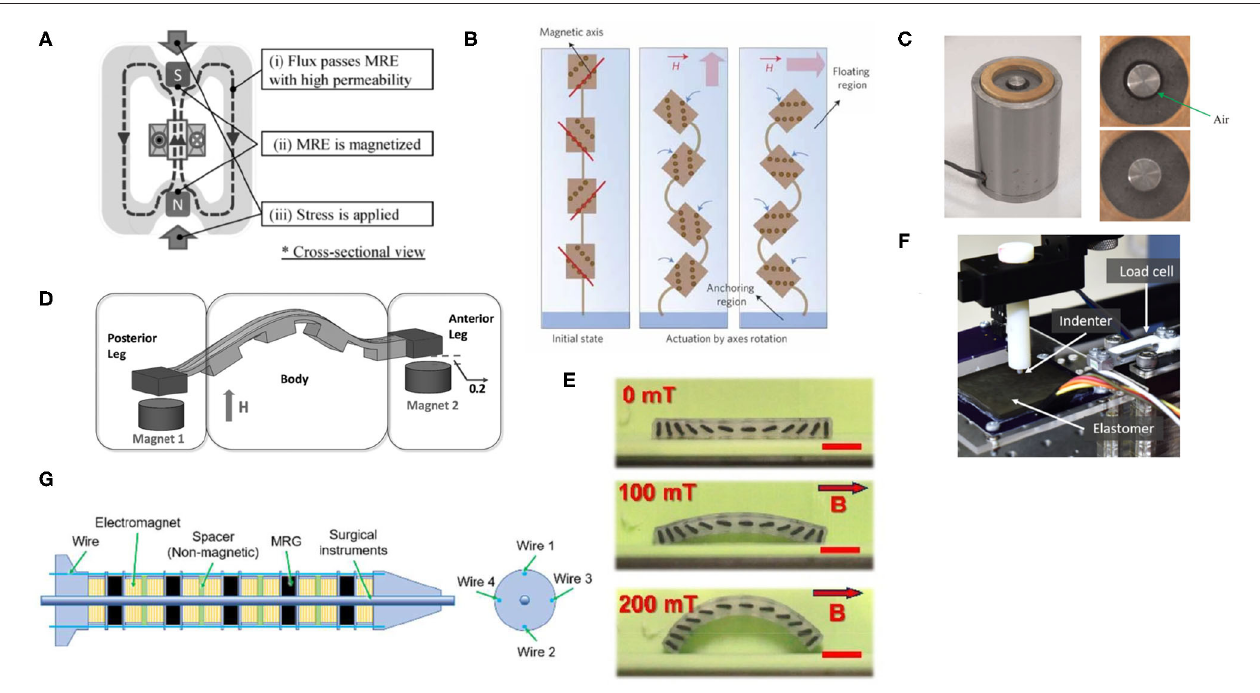
FIGURE 3 | A compilation of sMEs and their soft robotic applications: (A) a magnetostriction-based actuator utilizing an electromagnet core to contract the sME shell (Kashima et al., 2012), (B) a linkage of sMEs with aligned particles at 90 ◦ offsets, enabling linkage rotation depending on the direction of the applied H field (Kim et al., 2011 ), (C) a pneumatic valve composed of an sME around a solid core (Böse et al., 2012), (D) an inchworm soft robot with sME anchor points for an inchworm-like gait ( Joyee and Pan, 2019), (E) an applied field causing shape deformation of embedded 3D-printed magnetic elements in silicone (Qi et al., 2020), (F) a sME-based sensing skin coupled with Hall effect sensors and a neural network to localize deformations (Hellebrekers et al., 2020), and (G) a variable stiffness manipulator utilizing electromagnets and sMEs to control flexion joint angles ( Kitano et al.,